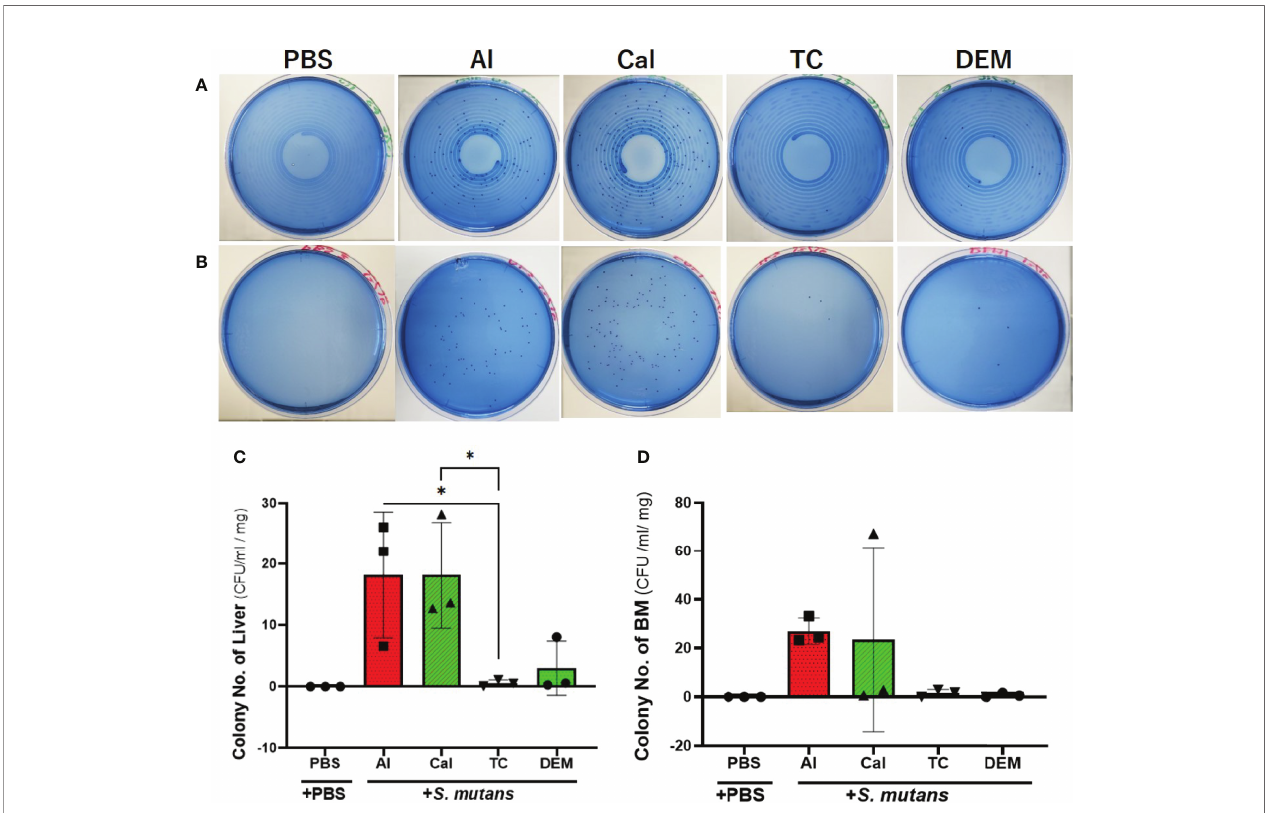
FIGURE 2 | Tetracycline-related fl uorescent reagents affected colony formation. Bacteriological analysis of one-day experiment comparing the effects of 4 different fl uorescent reagents on the bacterial colony formation in S. mutans -infected mice. (A) Culture-plate images of liver-derived colonies after one day of S. mutans inoculation. (B) Culture-plate images of bone marrow (BM)-derived colonies after one day of S. mutans inoculation. (C) The number of colonies derived from liver. (D) The number of colonies derived from bone marrow tissue. PBS, phosphate buffer saline; Al, alizarin; Ca, calcein; TC, tetracycline; DEM, demeclocycline. +PBS, intravenously PBS-injected group; + S. mutans , intravenously S. mutans -inoculated groups. The variance of data was analyzed by the Levene test. The comparison between groups was analyzed by the Kruskal Wallis test and the Wilcoxon rank-sum test. Values are expressed as the mean ± SD, *p <